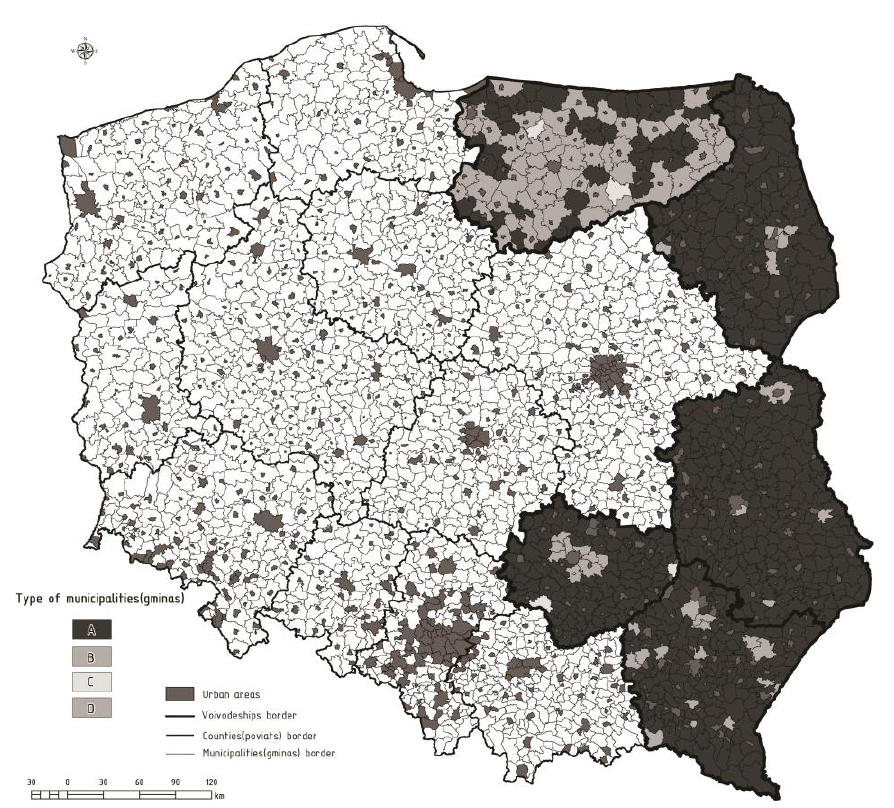
Fig. 11. Classification of rural areas of Eastern Poland with an unbalanced demographic structure (Source: authors’ own